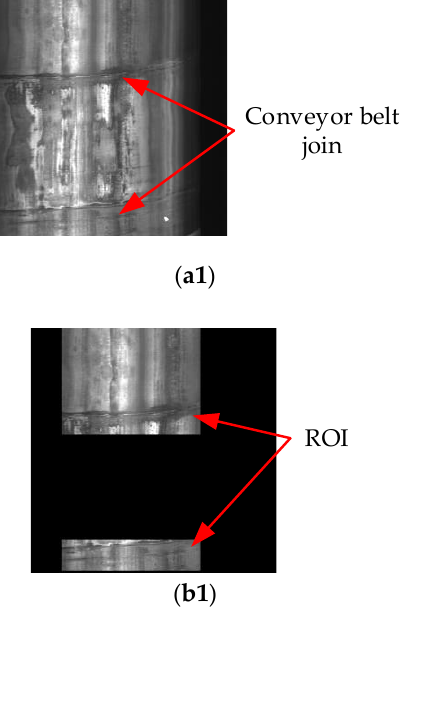
Figure 8. Partition operation for the IOI. ( a ) Image of interest (IOI). ( b ) Partition results. ( c ) HM 1 ( u ) curve. ( d ) VD 1 ( v ) curve. ( e ) HM 1 ′ ( u ) curve. ( f ) VD 1 ′ ( v ) curve. ( g ) B HM1 ( u ) curve. ( h ) B VD1 ( v ) curve. ( i ) B HM1 (cid:48) ( u ) curve. ( j ) B VD1 (cid:48) ( v ) curve.